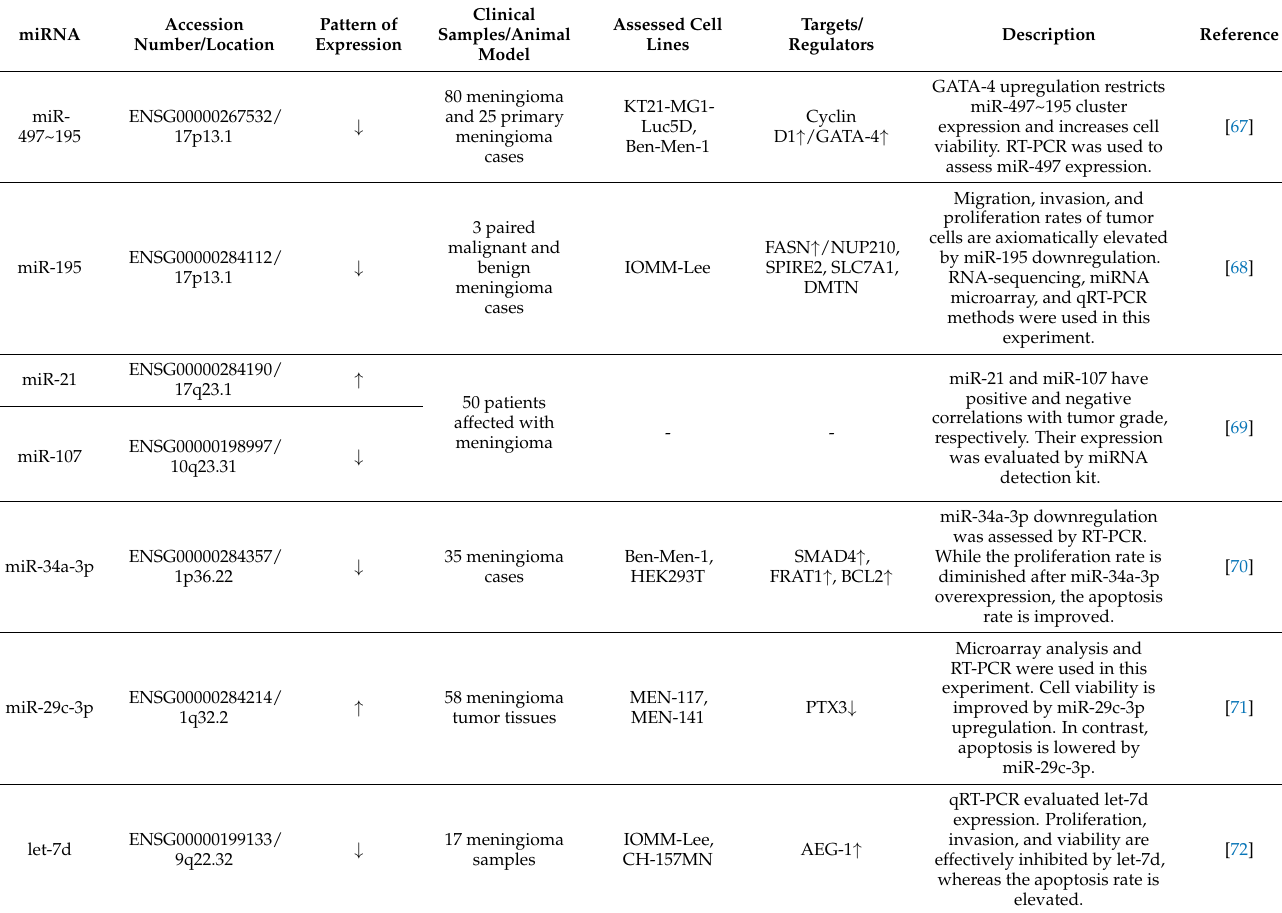
Table 6. miRNAs and meningioma.